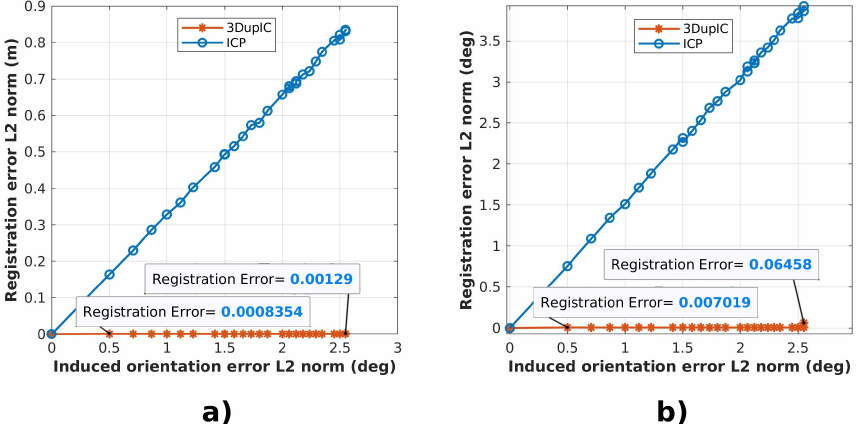
Figure 5. Induced errors in the initial orientation cause ( a ) position and ( b ) orientation registration errors, with respect to angular disturbance, represented in the horizontal axis. The vertical axis corresponds to the average registration error, computed from the experiments executed for each corresponding sampled disturbance